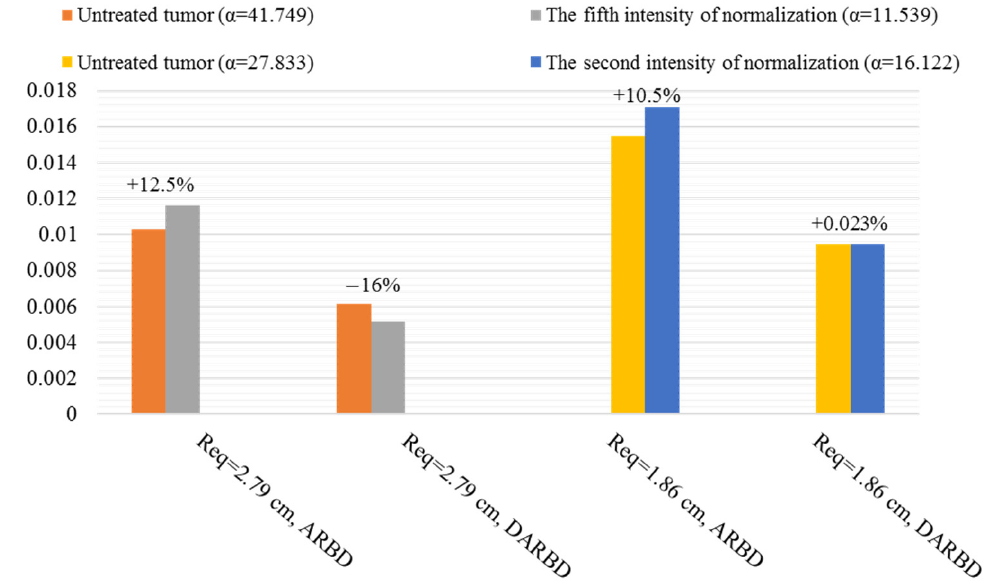
Figure 15. Summary of the positive influence of normalization on ARBD and DARBD of IgG in different sizes. The percentage of change after applying the AAIN is seen above the bars.